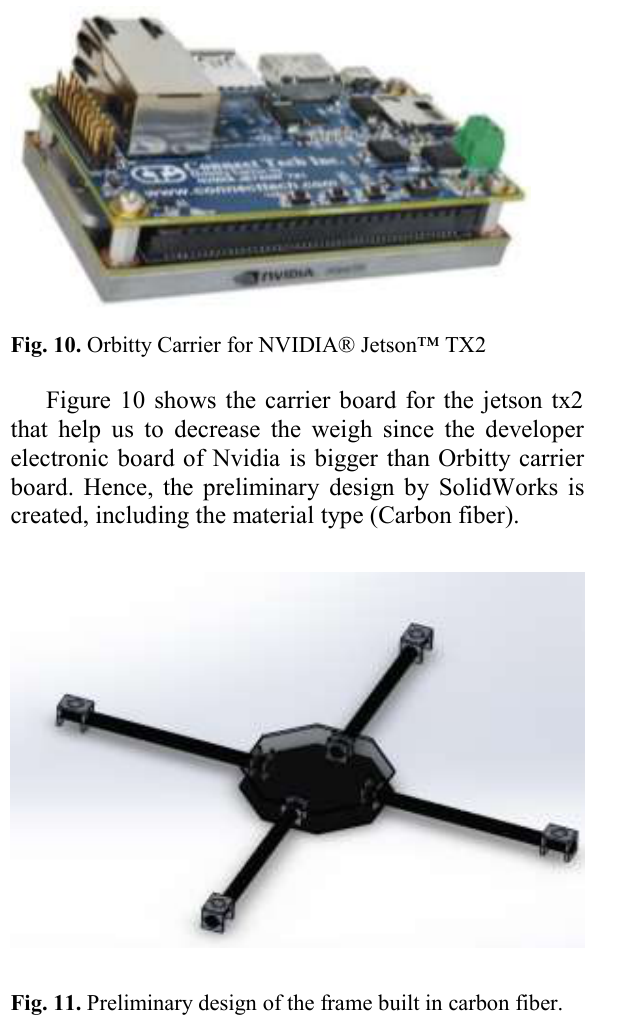
Fig. 11. Preliminary design of the frame built in carbon